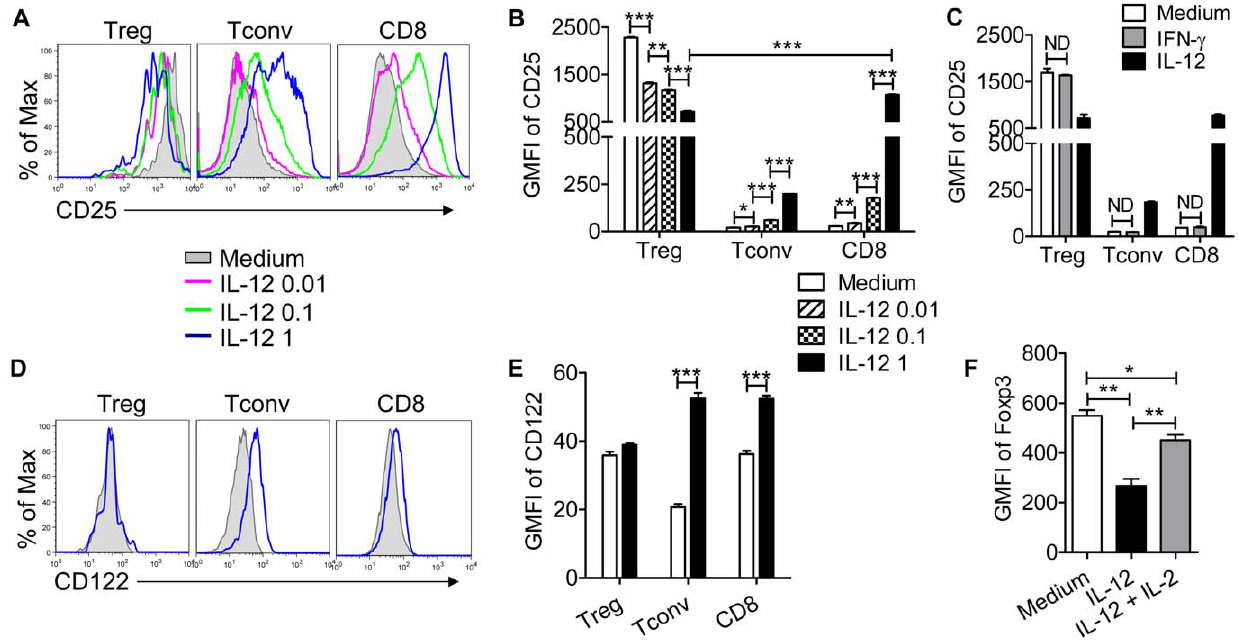
Figure 9. IL-12 has opposite effects on IL-2R expression by Tregs vs non-Treg T cells. Lymphocytes were prepared from naı¨ve Foxp3 gfp mice and treated with anti-CD3 mAb and IL-12 or IFN- c for 66 hr. (A, B) CD25 expression was decreased on Tregs and increased on Tconvs and CD8 T cells by IL-12 in a dose-dependent fashion. Representative histograms are shown in (A) and summary data are shown in (B). (C) IFN- c did not affect CD25 expression by Tregs and non-Treg T cells (ND-no difference). (D, E) IL-12 increased CD122 expression on Tconvs and CD8 T cells but not on Tregs. Representative histograms are shown in (D) and data are summarized in (E). (F) IL-12 diminished Foxp3 GMFI in Tregs and this was largely reversed by IL-2 (100 U/ml) treatment. Data are representative of three independent experiments performed in triplicate. * P , 0.05, ** P , 0.01, *** P , 0.001, Student’s two-tailed un-paired t tests.